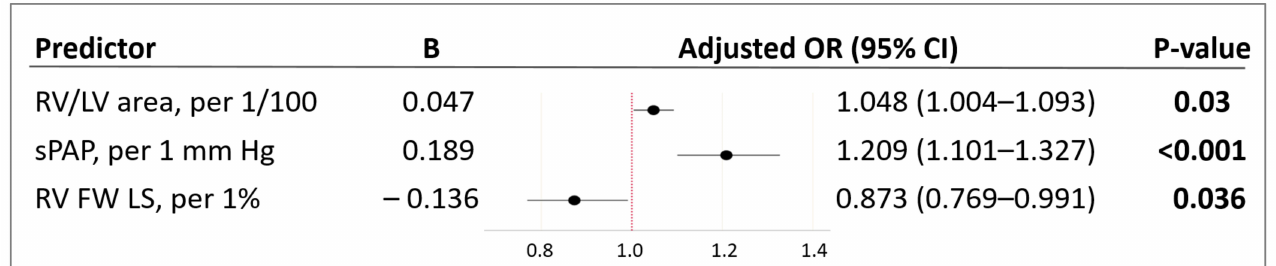
Figure 2. Characteristics of predictors included in the model (1). B—value of the coefficient in the equation; OR—odds ratio of mortality; 95% CI—95% confidence interval; RV/LV area—right ventricle to left ventricle area ratio; sPAP—systolic pulmonary artery pressure; RV FW LS (2D STE)—right ventricle free wall longitudinal strain (two-dimensional speckle-tracking echocardiography). Bold indicates significance ( p -value of < 0.05).